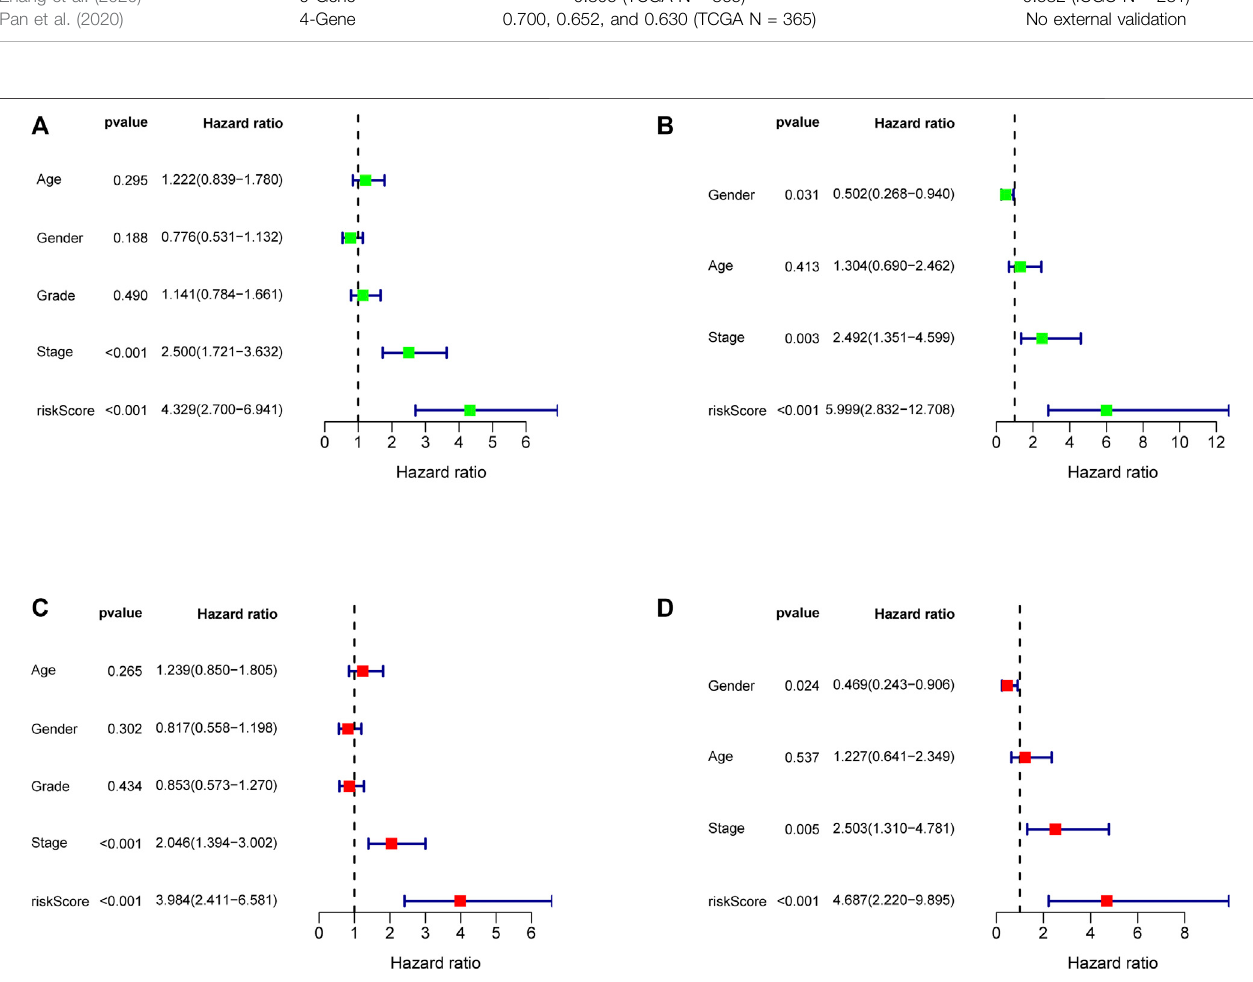
FIGURE 6 | Forest map of univariate and multivariate regression analyses in the TCGA discovery cohort (A, C) and the ICGC validation cohort (B, D) .